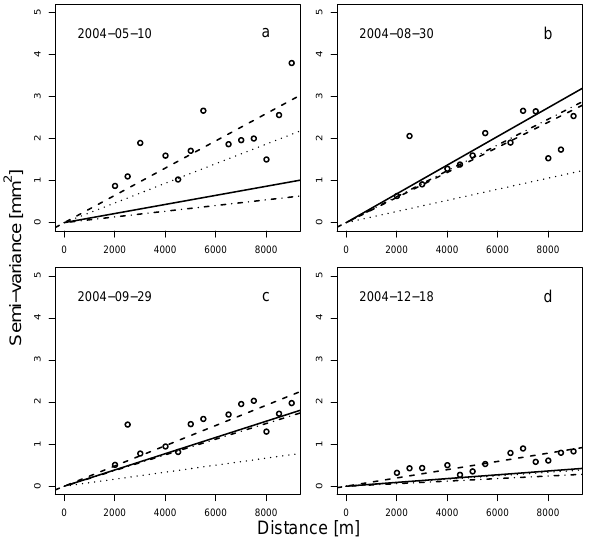
Fig. 12. Four examples of fitted variograms using only 10 gauges of the dense rain gauge network between March 2004 and March 2005. The dashed lines are the actual fits (UU-WUR), the dash- dotted lines are the fits through the KNMI data (KNMI), the solid lines are the fits found in Sect. 5.2.4 from the combined KNMI and UU-WUR rain gauge data (KNMI-UU-WUR), and the dotted lines are the climatological fits.